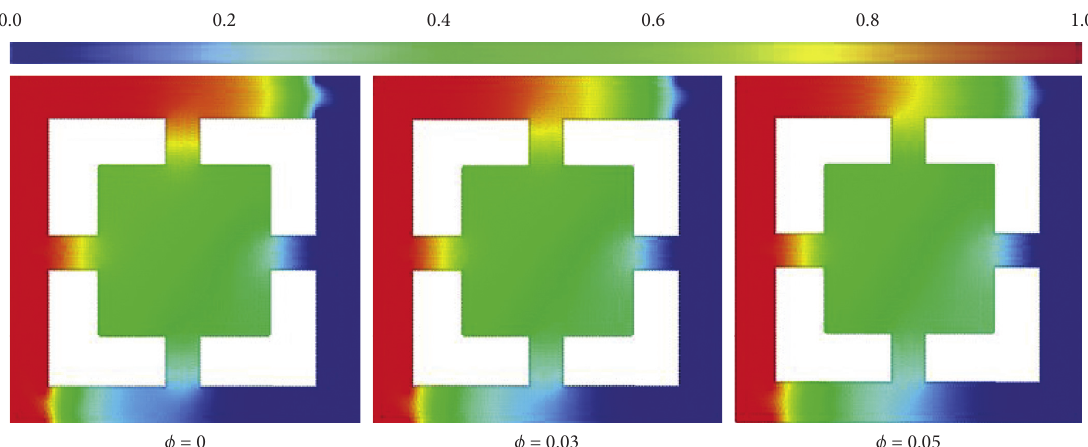
Figure 9: Features of temperature below variations of a solid volume fraction parameter at N � 1 , Ra � 10 4 , Da � 10 − 3 , η ε � 0 . 6 , Le � 20, and τ �